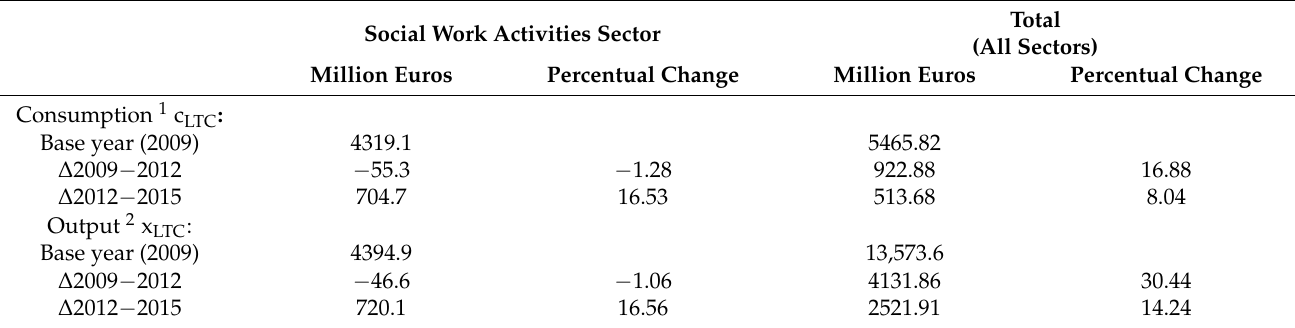
Table 2. Consumption and total output generated by LTC